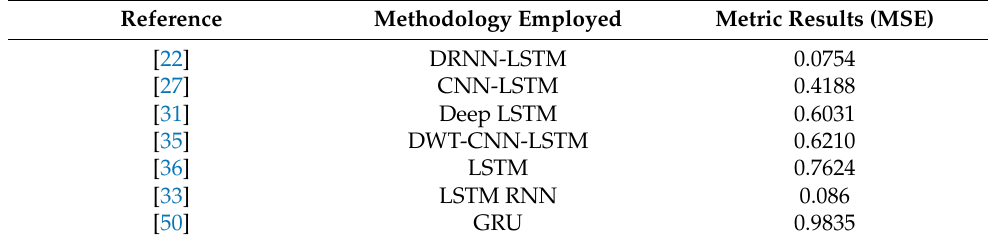
Table 1. Quantified results from the